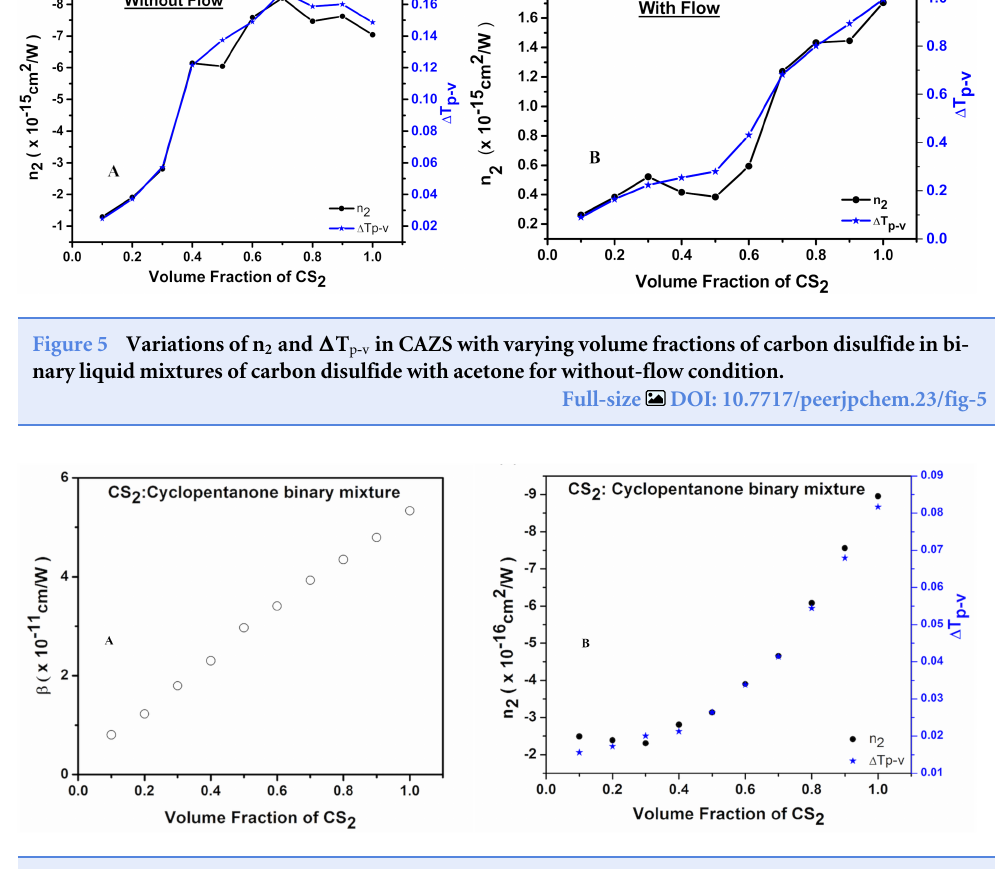
Figure 6 Variations in the respective NLO properties ( β ) and (n 2 ) with changing volume fraction of carbon disulfide in binary liquid mixtures of carbon disulfide with cyclopentanone in CAZS without- flow experiments. Full-size DOI: